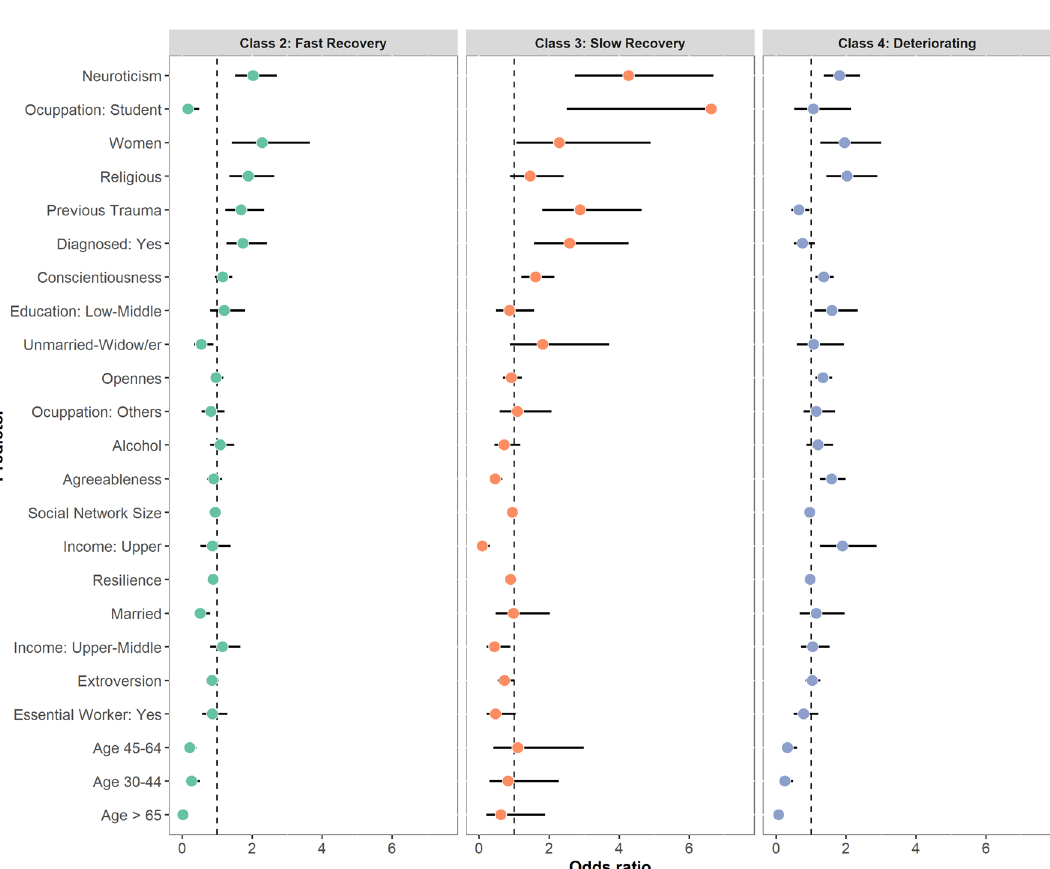
Figure 3. Risk and protective factors for Psychological Distress associated with trajectories by multinomial Logistic regression. Class 1 (Resilient) served as reference. Results are expressed as odds ratio with 95% CI. Due to their small size, the following categories were combined for analysis: Education: middle and high levels were combined into middle-high level; Marriage status: Unmarried and Widow/er were combined into Unmarried- Widow/er; Income: Lower and middle were combined into Lower-Middle; Employment status: Retiree, House Wife and Unemployed were combined into